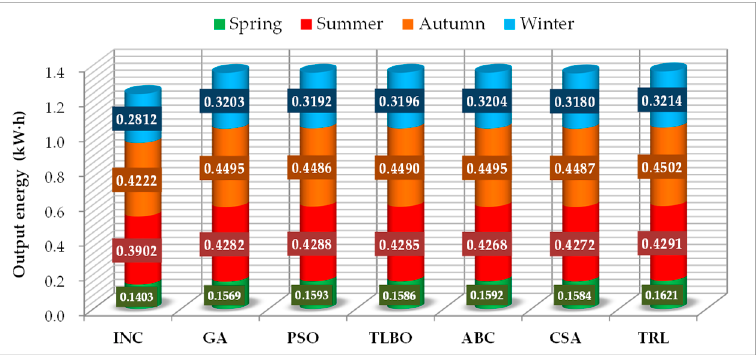
Figure 13. Statistical results of output energy of the PV system obtained by seven algorithms in different seasons.